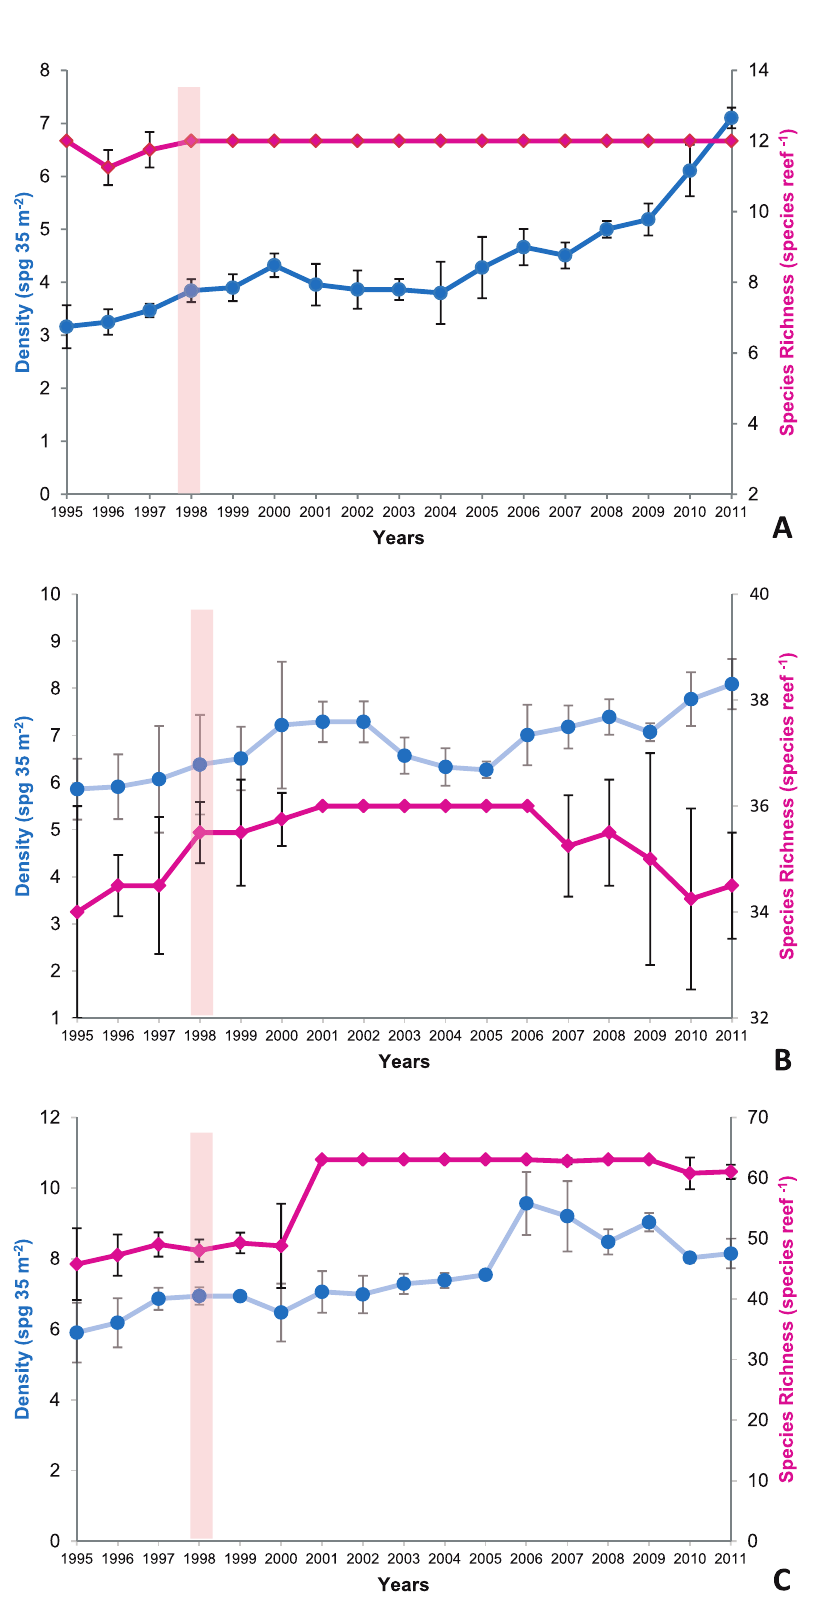
Figure 3. Changes in density and species richness (Mean ± SE) of the sponge assemblage recorded over a 17-year period (1995– 2011) in Bahia, Brazil. Vertical bars represent the timing of the severe 1997–8 El Nin˜o.